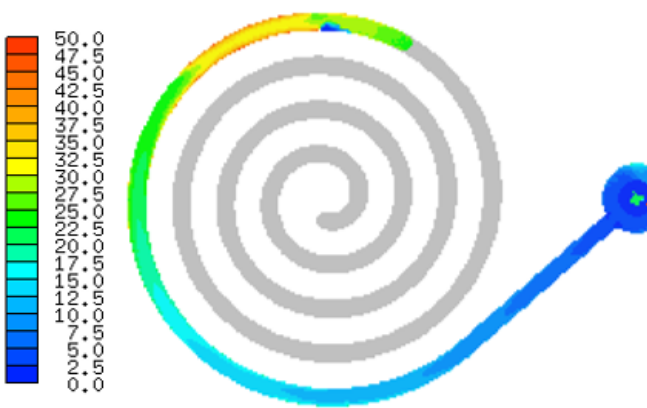
Figure 9. Spiral cavity copper alloy experiment results and simulation